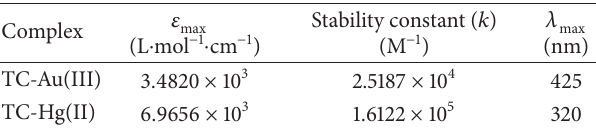
Table2:Stabilityconstant( 𝑘 )andmolarabsorptivityforTC-Au(III) and TC-Hg(II) complexes in